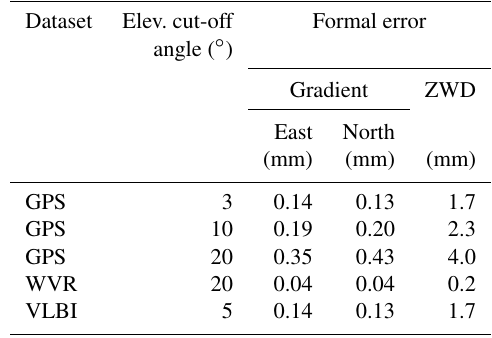
Table 4. Formal errors of the remote-sensing techniques.